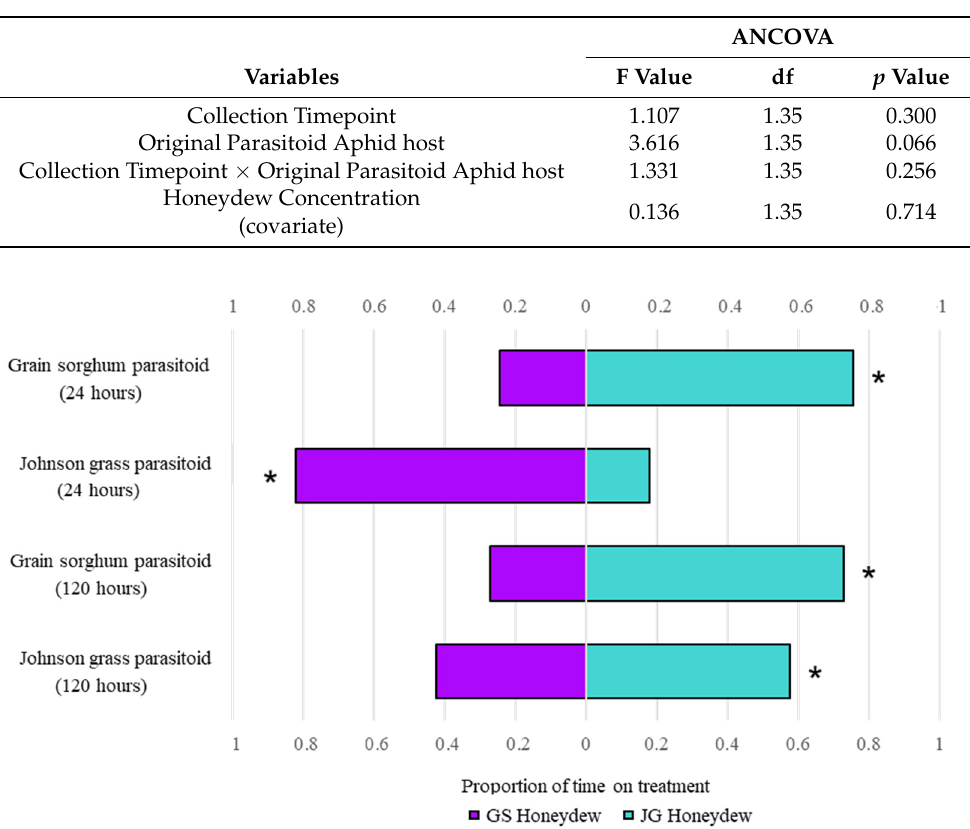
Figure 4. Both grain sorghum and Johnson grass parasitoids preferred Johnson grass honeydew, except for Johnson grass parasitoids at the 24-h timepoint (one-sample t -test). As per a one-sample t -test, an asterisk indicates statistical significance at p < 0.05.